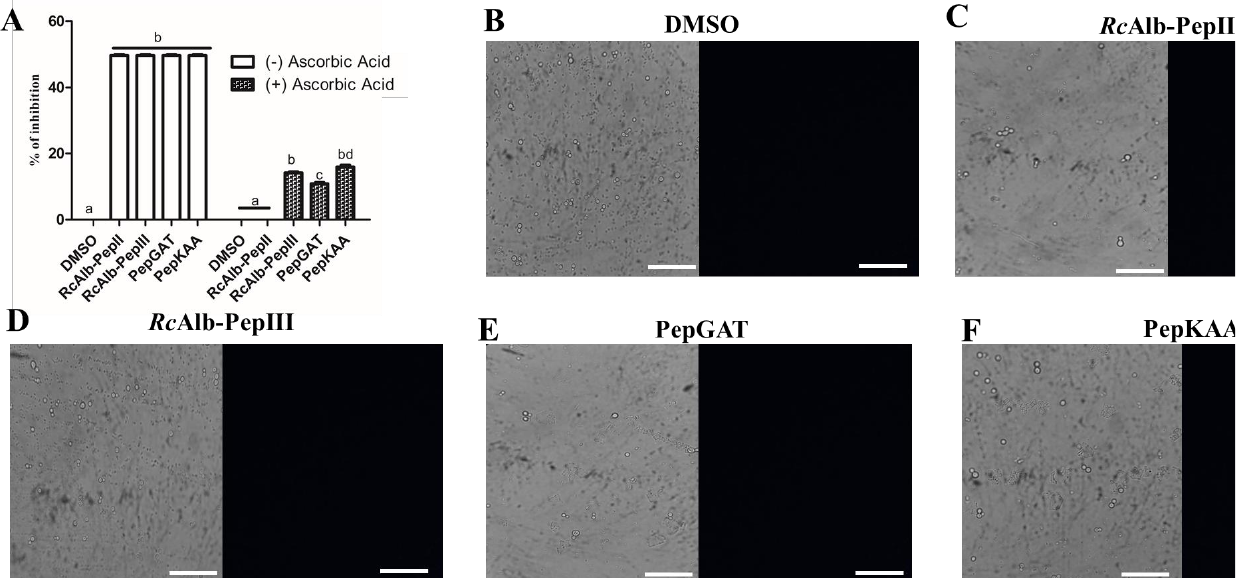
Figure 4. Effect of the antioxidant agent, ascorbic acid, in the activity of synthetic peptides against C. neoformans . (A) Inhibitory activity of synthetic peptides against C. neoformans in the presence of 10 mM of ascorbic acid. (B-F) Fluorescence microscopy analysis showed no detection of H 2 O 2 in the cells of C. neoformans in the presence of 10 mM of ascorbic acid. Bars indicate 100 μm. The different lowercase letters in (A) i ndi- cates statistical significance at p > 0.05.